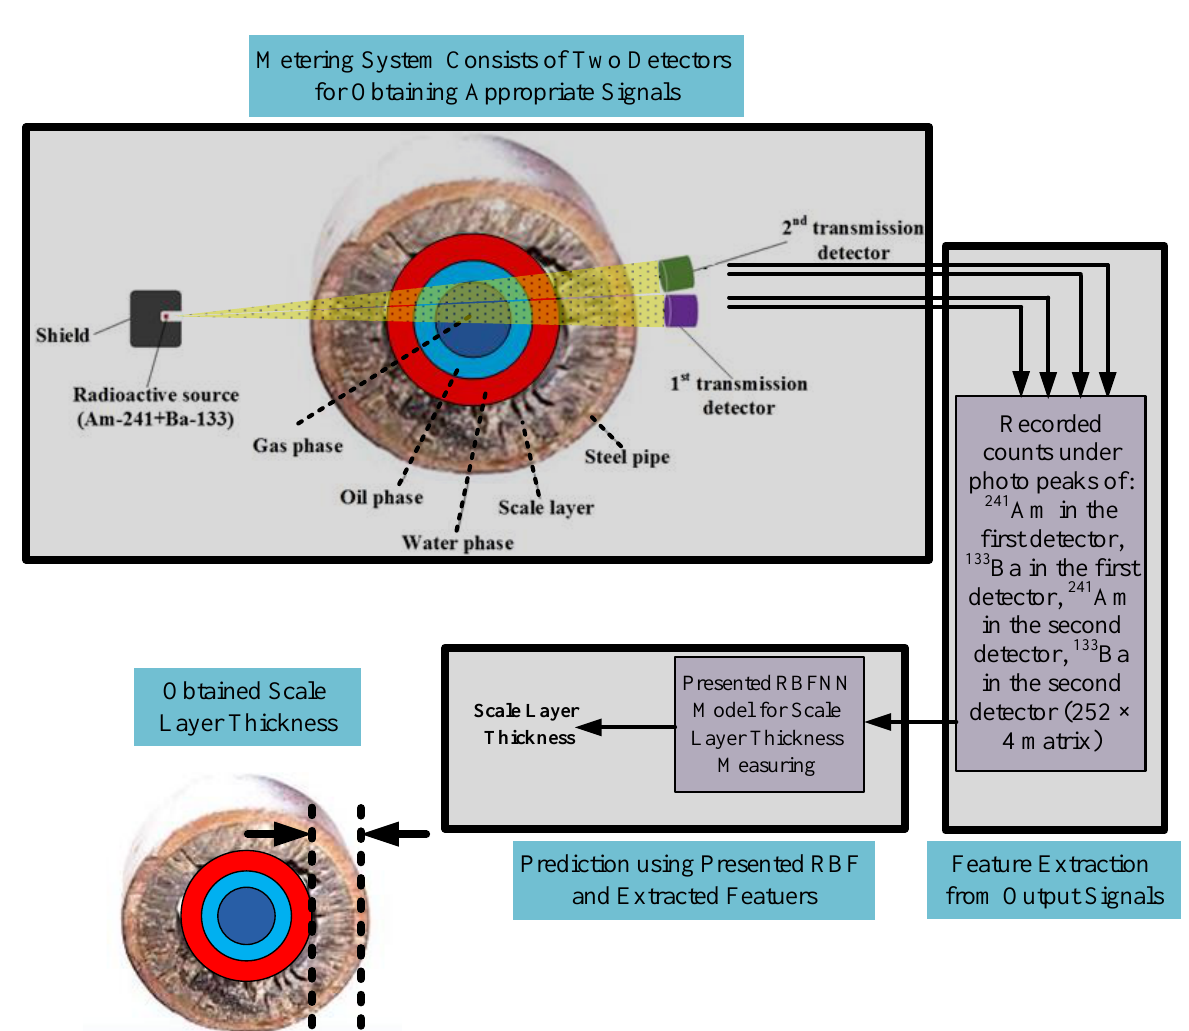
Figure 4. The conceptual procedure for scale layer thickness metering.